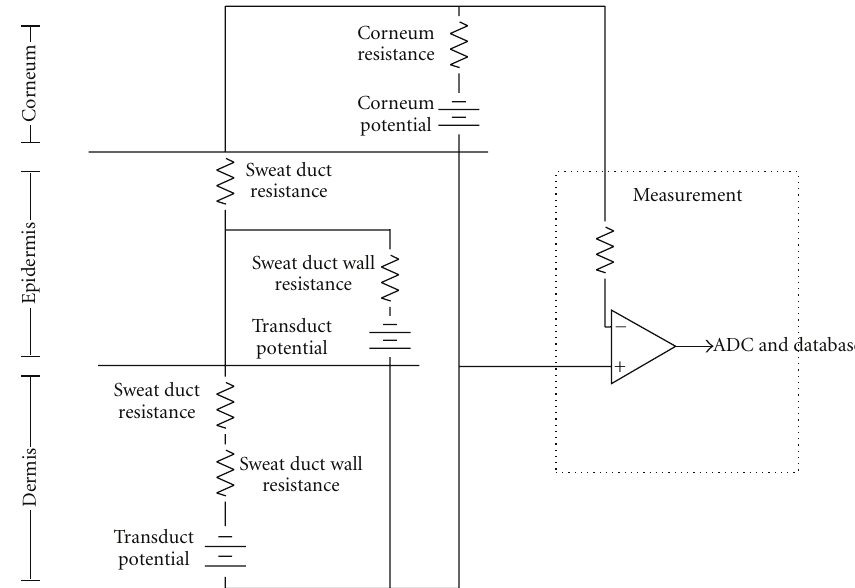
Figure 6: A simplified equivalent circuit describing the electrodermal system; redrawn from [26].